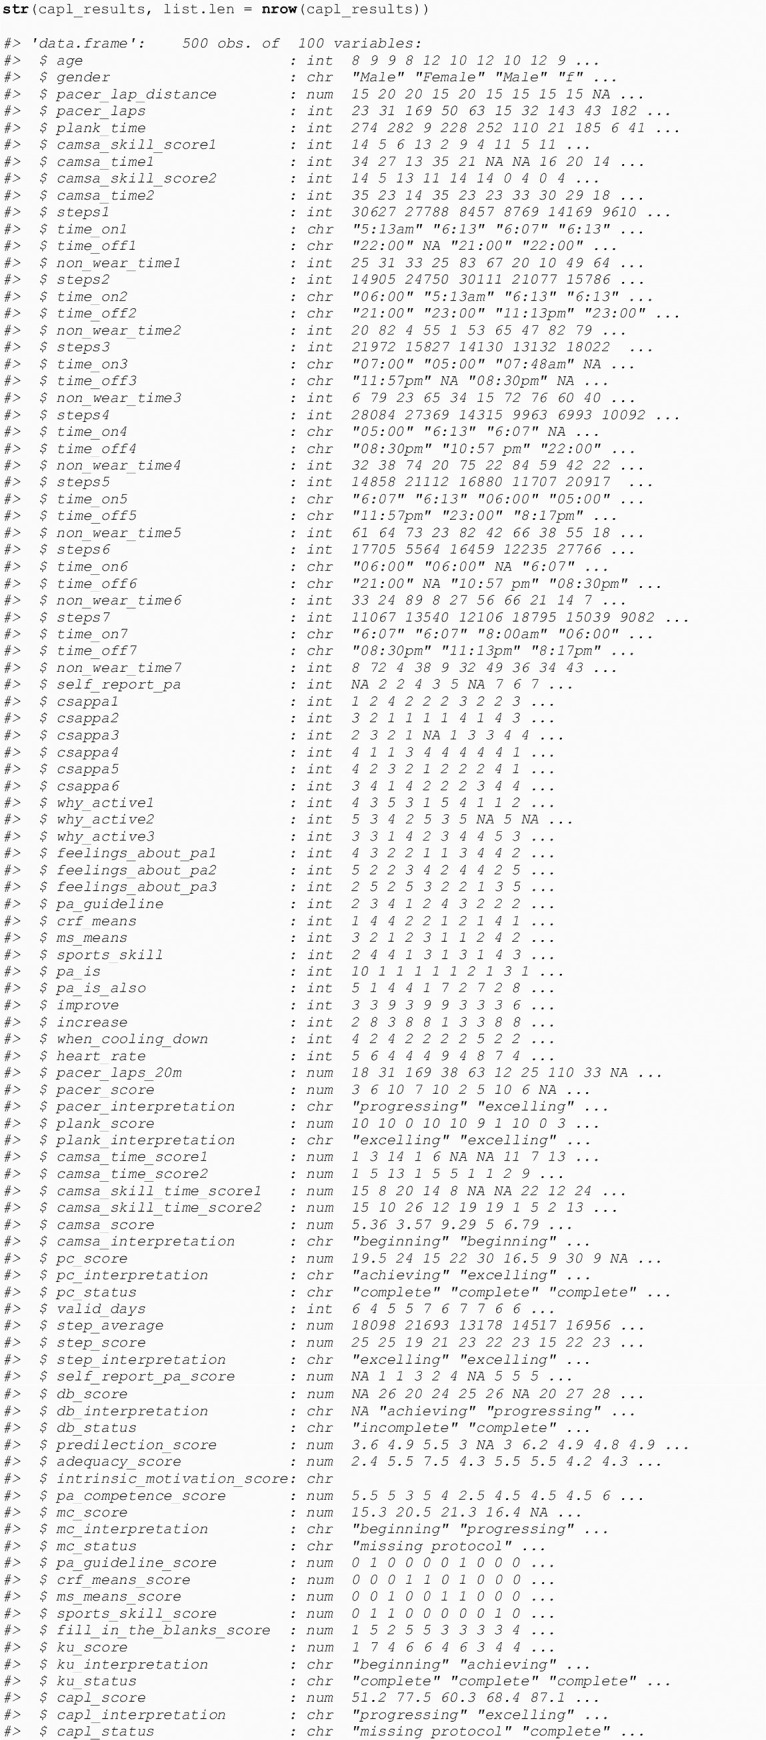
Confirmation of forty new computed variables.